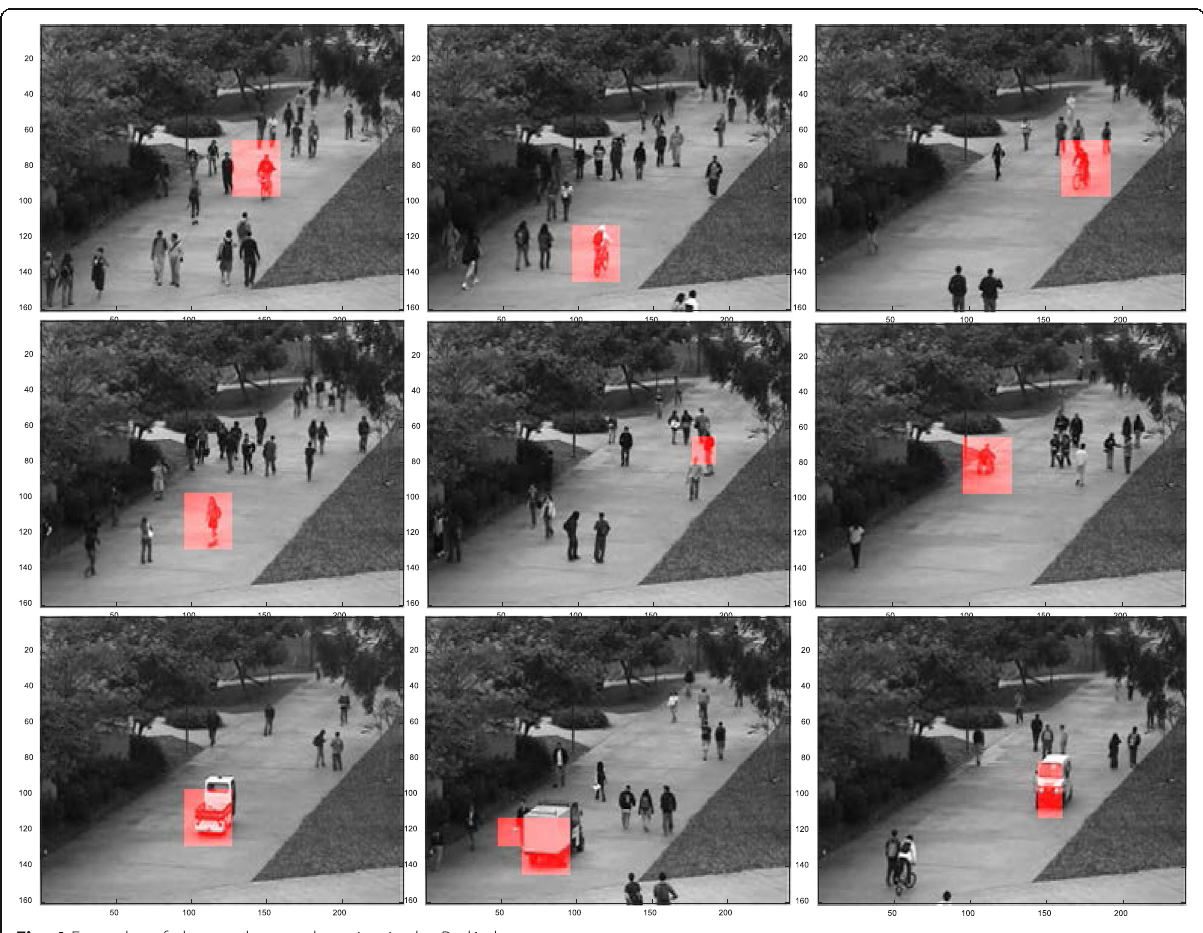
Fig. 4 Examples of abnormal event detection in the Ped1 dataset